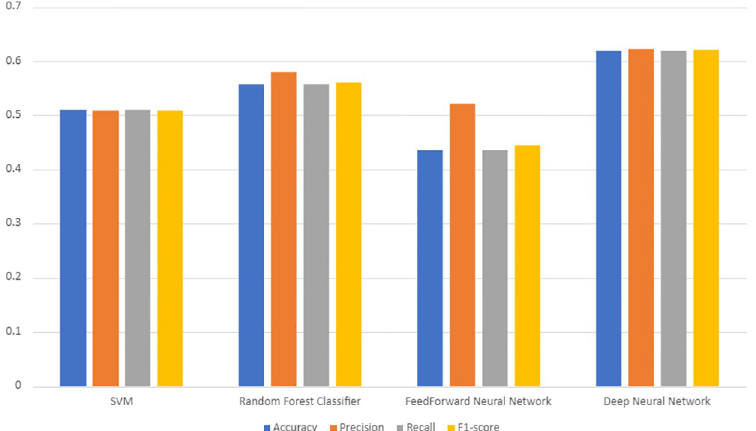
Fig 4. Performance metrics of the different machine learning techniques on LOOCV. Accuracy indicates the percentage of correct predictions. Precision is a measure of quality that indicates the percentage of relevant samples among selected samples. Recall is a measure of quantity that reflects the percentage of the relevant samples that were actually selected. F1-score is identified as a more sensible measure of accuracy of a model that is calculated using precision and recall. Higher the better for all metrics.